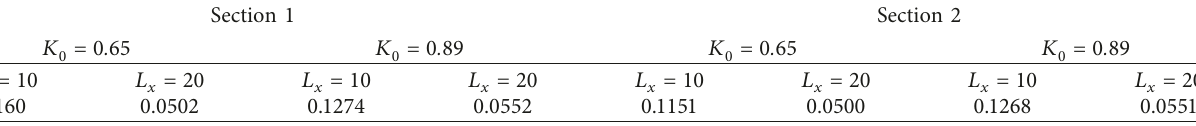
Table 3: Calculation results of the η value.